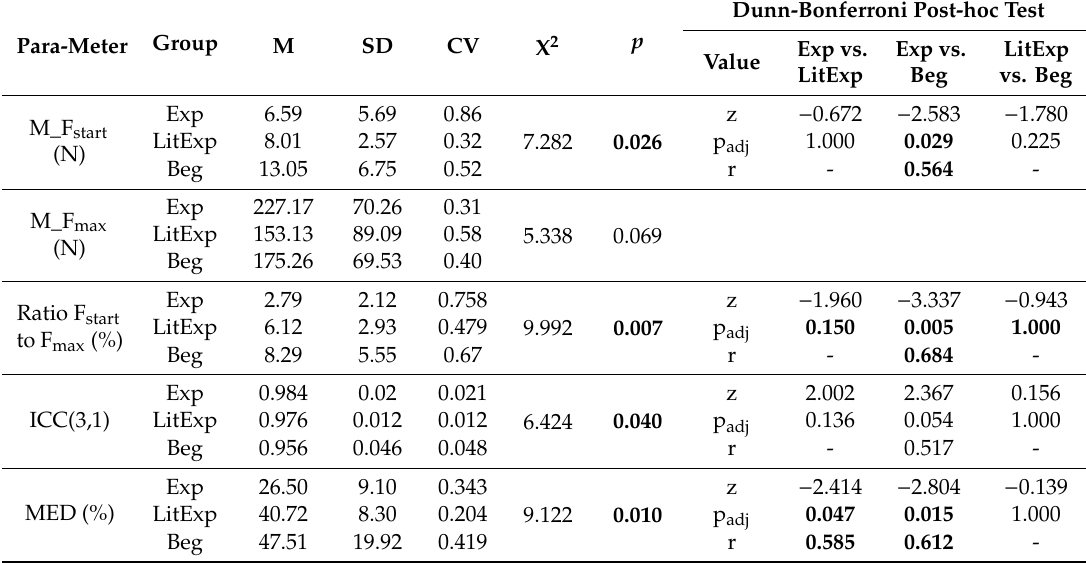
Table 3. Inter-group comparisons of force parameters, normalized mean Euclidean distance (MED) and intraclass correlation coe ffi cient (ICC(3,1)). Arithmetic means (M), standard deviations (SD), coe ffi cients of variation (CV) and statistical results of Kruskal–Wallis test (Chi-square ( χ 2 ), significance p ) for group comparisons between experienced (Exp), little experienced (LitExp) and beginners (Beg) of the parameters starting force (M_F start , (N)), maximum force (M_F max , (N)), ratio of F start to F max (%), ICC(3,1) and MED (%). For significant results, the pairwise comparisons of Dunn–Bonferroni